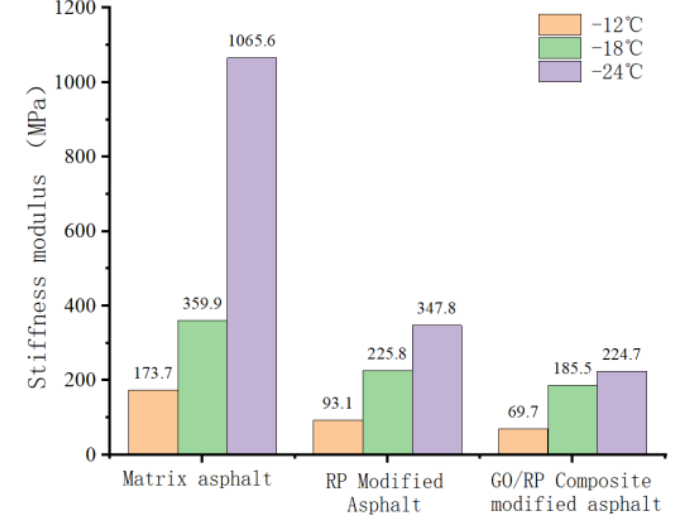
Figure 8. Stiffness modulus of asphalt at different temperatures.